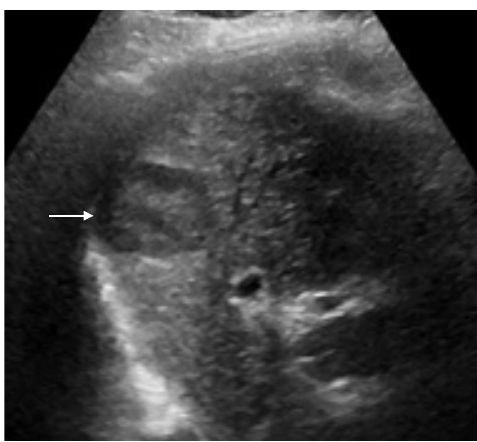
Figure 1 In the gray-scale ultrasonography showed a hypoechoic nodule in the right posterior lobe of